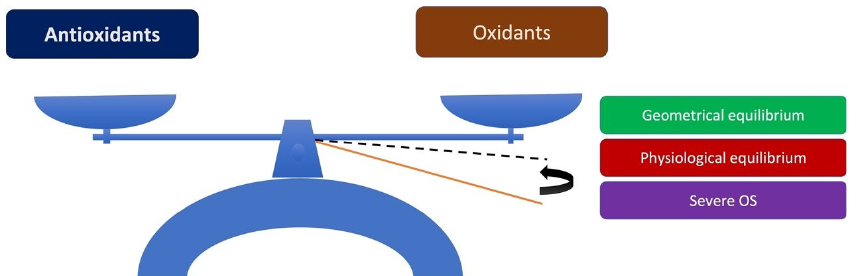
Figure 1. Model of normal and disturbed antioxidant/oxidant equilibrium. The physiological equilibrium is represented by a black dashed line, while the severe OS is represented by a solid orange line.